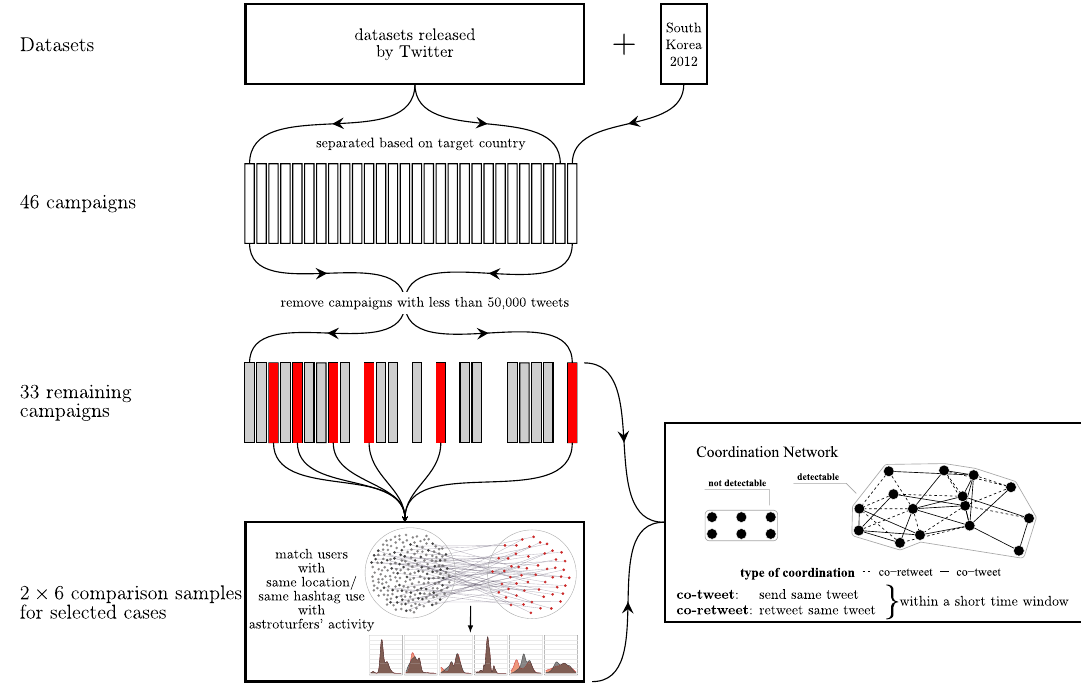
Figure 1. Research design. Datasets, case selection and analysis